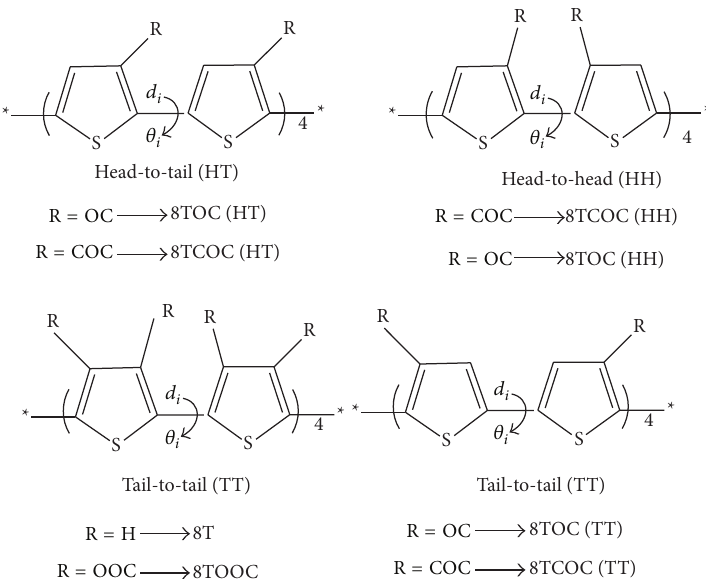
Figure 1: Sketch map of the structures, length bond, and dihedral